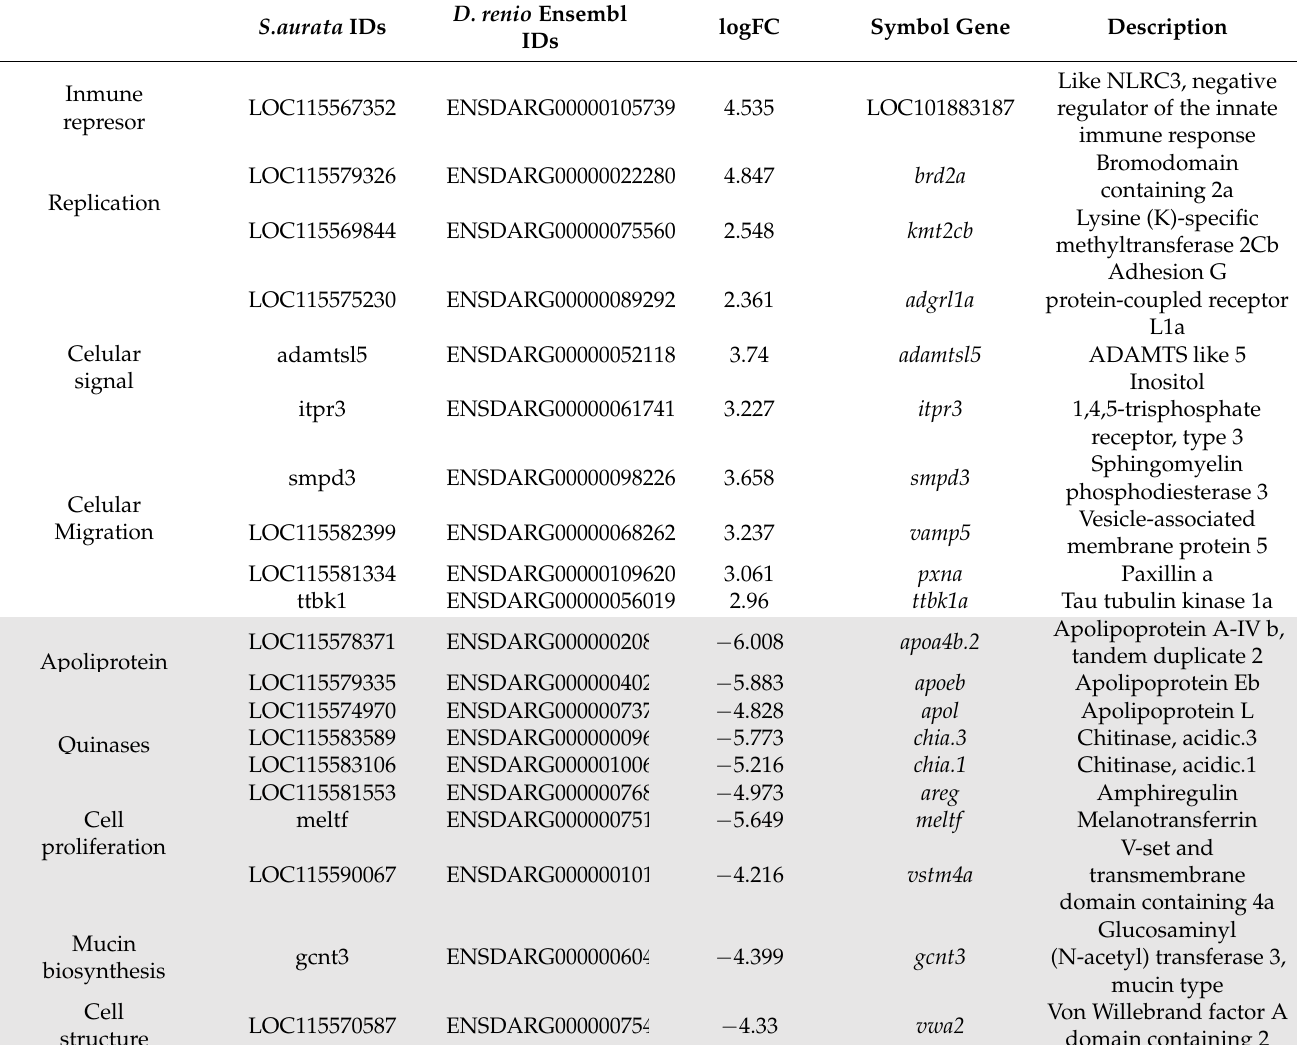
Table 2. Top 20 genes found to be significantly up- and down- regulated in PW compared to